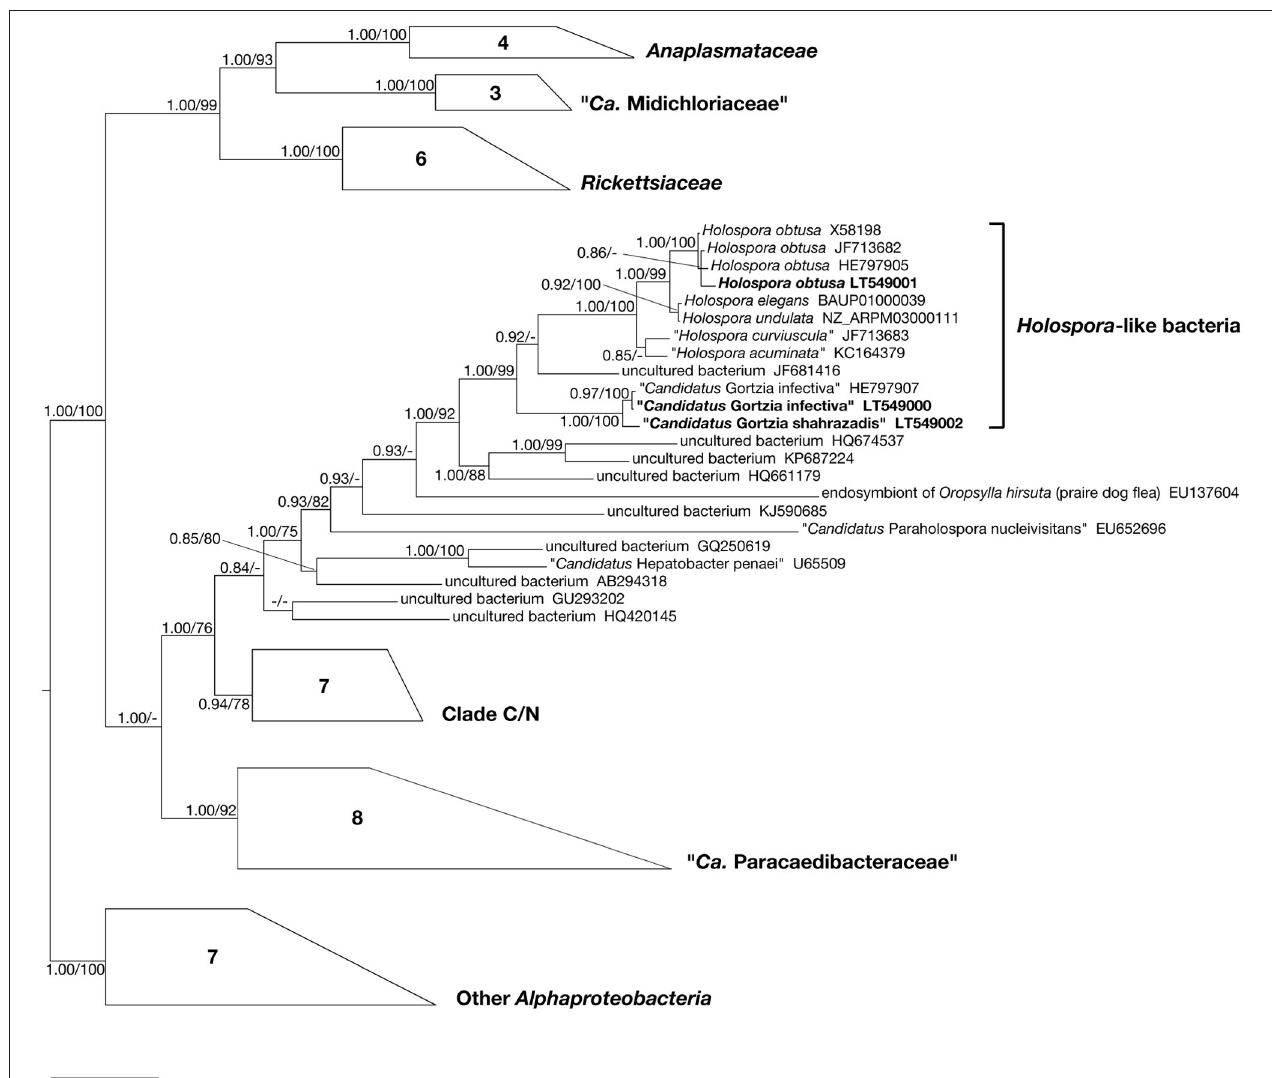
FIGURE 6 | Bayesian inference tree of the order Rickettsiales based on 16S rDNA sequences. Numbers associated to nodes represent posterior probabilities and maximum likelihood bootstrap values, respectively (only values above 0.80–70 are shown). Numbers inside trapezoids correspond to sequences used to represent that clade. Sequences obtained in the present work are in bold characters. Bar stands for an estimated sequence divergence of 6%.